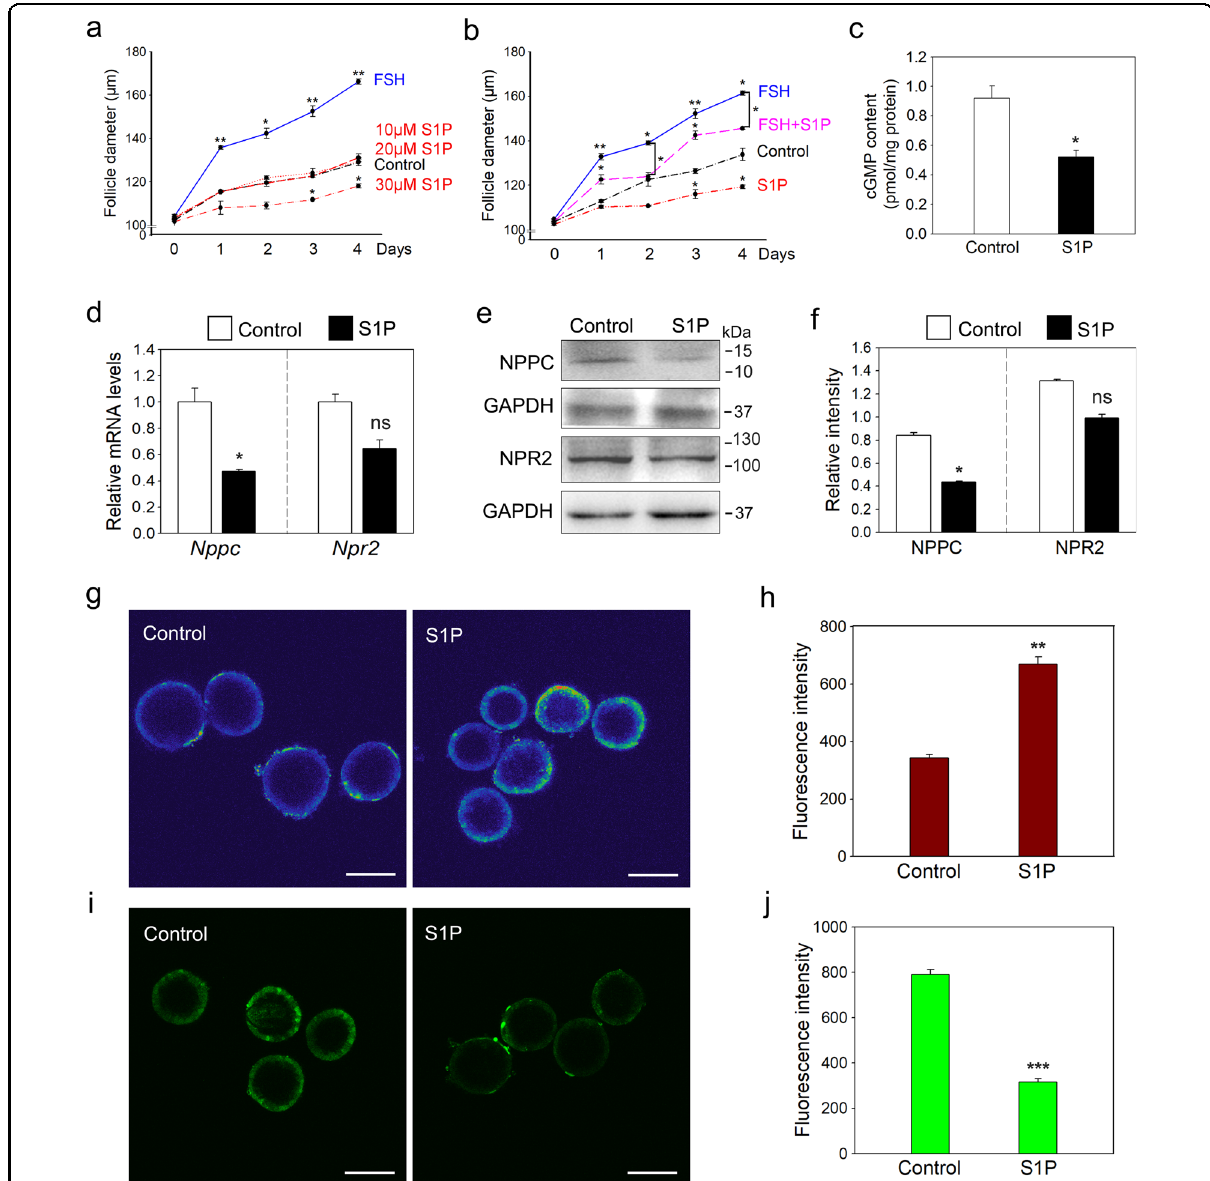
Fig. 4 The effects of S1P on NPR2 activity and preantral follicle development. a The effect of S1P (10, 20, 30 μ M) or FSH (25 ng/ml) on preantral follicle growth. * p < 0.05 and ** p < 0.01 compared with the corresponding control. ( n = 3 independent experiments. The total number of 36 secondary follicles was used in each group). b The effect of S1P on FSH-induced follicle growth. Preantral follicles were treated with FSH (25 ng/ ml) and/or S1P (30 μ M) for 4 days, and the diameters of follicles were measured daily. * p < 0.05 and ** p < 0.01 compared with the corresponding control. The diameters in the S1P + FSH group were signi fi cantly decreased compared with those in the corresponding FSH group. * p < 0.05. ( n = 3 independent experiments. The total number of 36 secondary follicles was used in each group). c Cyclic GMP levels in ovaries from the control and S1P treatment groups ( n = 3 independent experiments. The total number of 12 ovaries was used in each group). The mRNA ( d ) and protein ( e , f ) levels of NPPC and NPR2 in ovaries from the control and S1P treatment groups ( n = 3 independent experiments). GAPDH was used as a loading control. Fluorescence images ( g ) and statistical analysis ( h ) of calcium in granulosa cells after incubation with Fluo 3-AM (pseudocolor). The fl uorescence intensity indicates the mean ± SEM. ( n = 3 independent experiments. The total number of 30 follicles was scored in each group). Fluorescence images ( i ) and statistical analysis ( j ) of the binding af fi nity of NPR2 for NPPC in granulosa cells after incubation with FAM-NPPC (green). The fl uorescence intensity indicates the mean ± SEM. ( n = 3 independent experiments. The total number of 21 follicles was scored in each group). Scale bars: 100 μ m. Bars indicate the mean ± SEM. ns no signi fi cance, * p < 0.05, ** p < 0.01 and *** p < 0.001 vs. the control